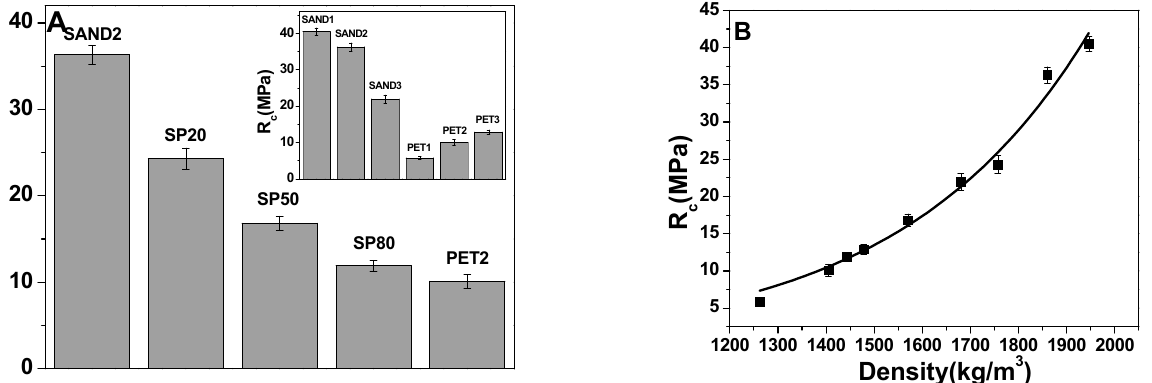
Figure 4. ( A ) Compressive strengths of SAND2, SP and PET2 samples (with 500 g of aggregate). In the inset: compressive strengths of bare SAND and PET specimens. ( B ) compressive strengths vs. sample density.